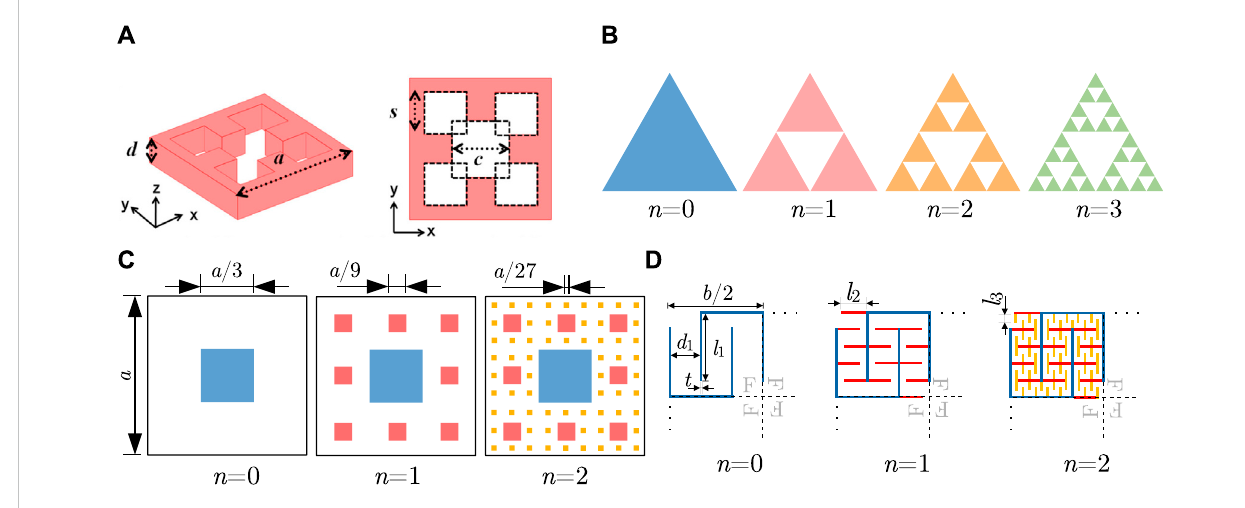
FIGURE 5 Fractal-like PCs and MMs. (A) Fractal-like square unit cell with a length of a , thickness d , and square features of dimensions c and s [reprinted from (Kuo and Piazza, 2011), with the permission of AIP Publishing]. (B) Sierpinski equilateral triangles with increasing fractal orders n . (C) Sierpinski carpet with increasing fractal orders n and unit cell length a , where the squares included in each new hierarchical order have a side length of a /3 n +1 . (D) Labyrinthine acoustic MM unit cell (one-quarter represented, F indicates the rotational symmetry of the unit cell), with light blue parts representing solid plates with a unit cell length b and thickness t , while white regions represent air; for the regular structure ( n =0) the characteristic lengths are given by d 1 and l 1 ; for the fi rst (second) hierarchical order n =1 ( n =2), structures with a length l 2 ( l 3 ) are included, as shown in red (yellow) [adapted from Liu et al.